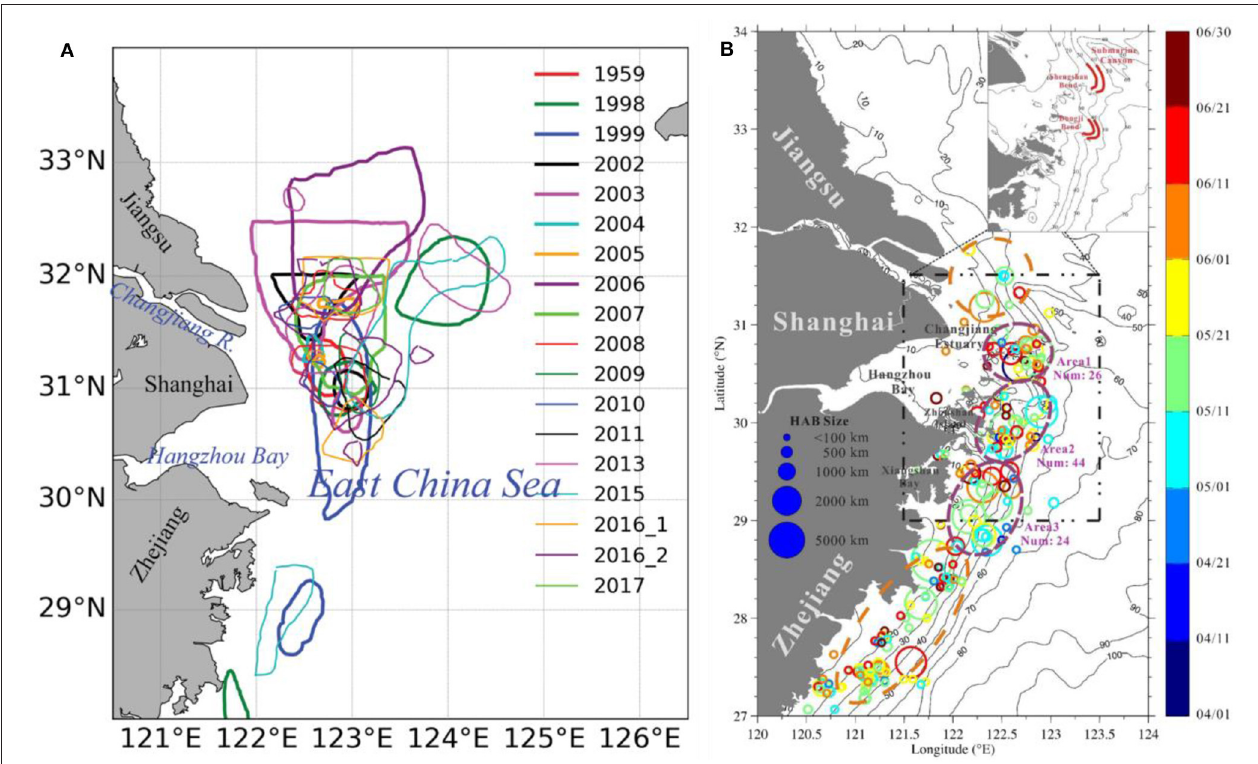
FIGURE 6 | Maps for (A) the observed distributions of bottom hypoxic waters (Zhang et al., 2019c) and (B) events of harmful algae bloom (HAB) between 2000 and 2014 (Wang Y. H. et al., 2019). “The color and size of the solid circle represent the date and affected area of each event. The black lines are the isobaths. Three HAB hotspots and two scattered HAB areas are marked with purple and orange dashed circles, respectively. The event occurrence numbers in HAB hotspots are also labeled” in (B) (Wang Y. H. et al.,